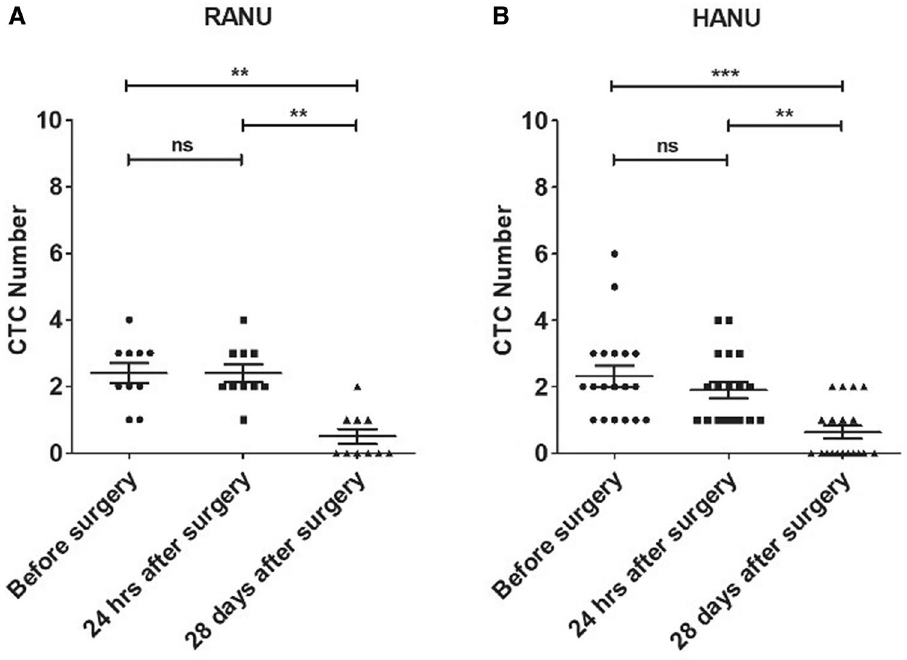
Figure 2. Time course analysis of CTC levels in UTUC. CTC levels were evaluated in before surgery and at 24 h and 28 days after surgery. Numbers of CTCs/7.5 ml are showed on the plots; ( A ) Results from patients who